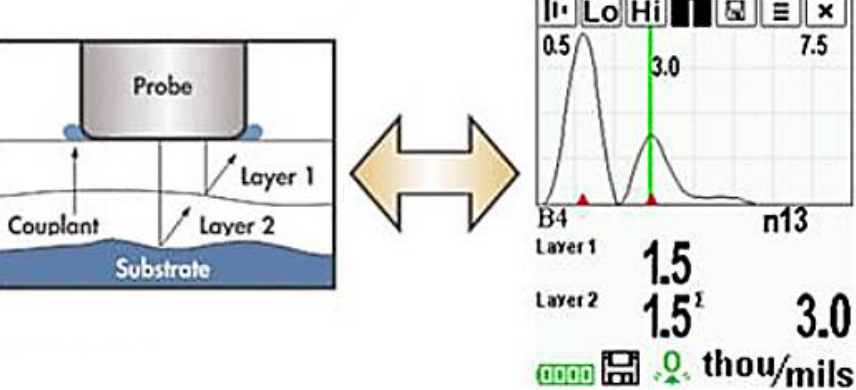
Figure 4. Application of ultrasonic testing to coating layers. (Adapted with permission from ref. [32]. Copyright 2004 DeFelsko).